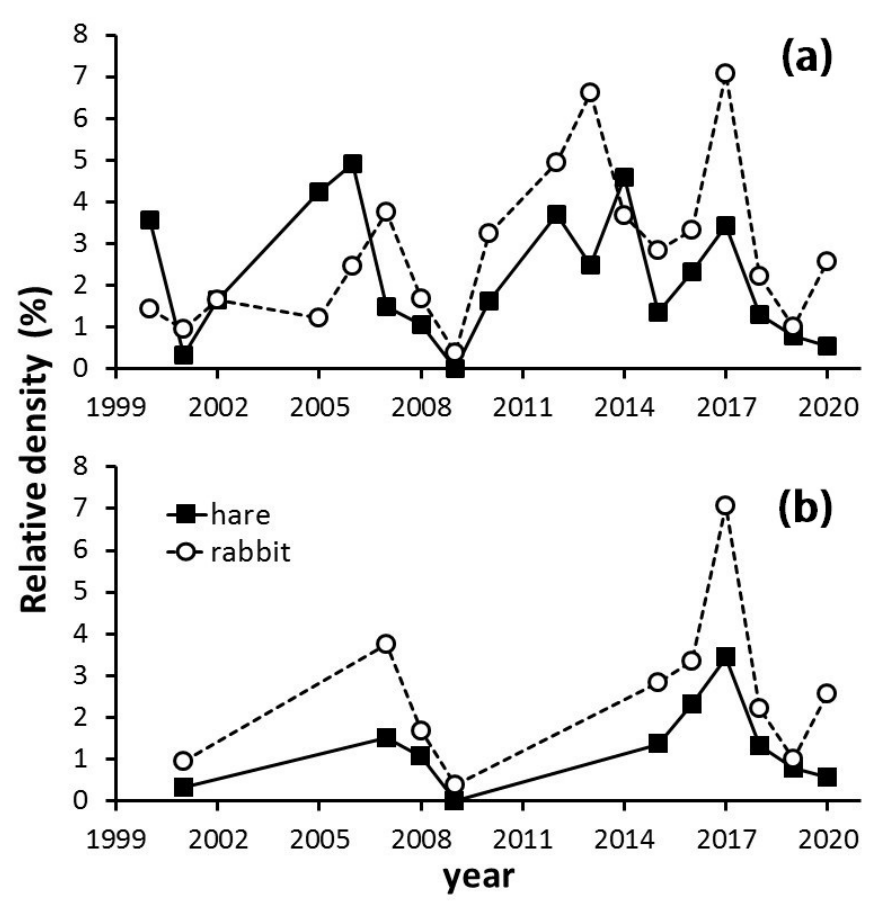
Figure 2. Temporal dynamics of the Iberian hare ( Lepus granatensis ) and rabbit ( Oryctolagus cuniculus ) in a Mediterranean agricultural area with high human population (S. Spain). Relative density is calculated as the number of individuals registered per year, corrected by the total number of localities × date × year in which registers were made ( × 100). ( a ) Years with more than 120 localities × date ( n = 18). ( b ) Years with more than 300 localities per date ( n = 10).